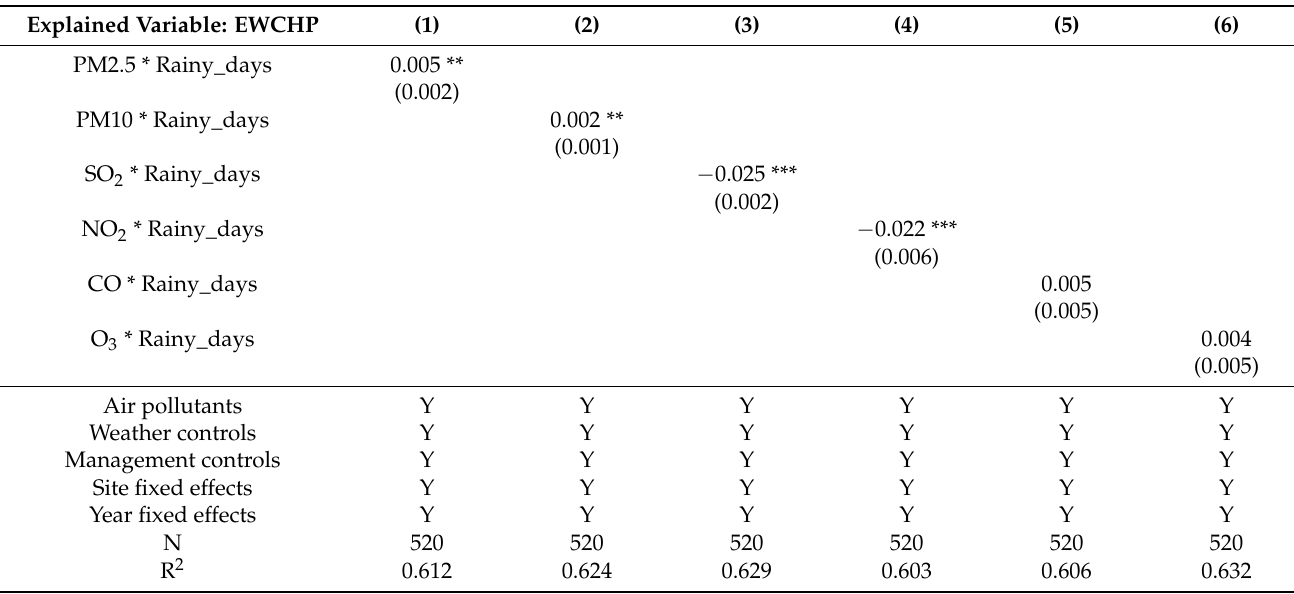
Table 6. Estimation of adjustment effect of